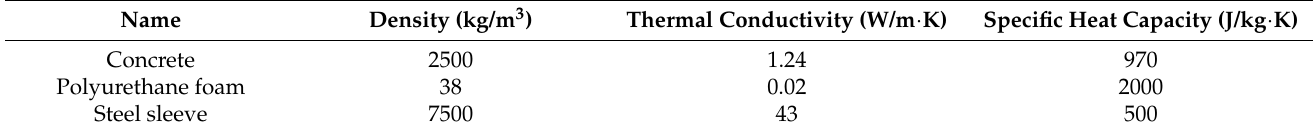
Table 2. Material thermal property parameters.